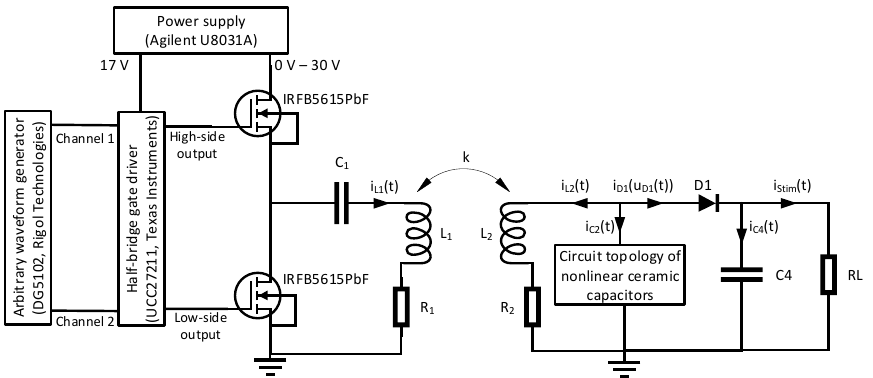
Figure 2. Inductively coupled system for power transfer consisting of an extracorporeal transmitter ( left ) and an implantable electronic circuit ( right ). The extracorporeal transmitter consists of a resonant half-bridge converter, a capacitor C 1 , an inductance L 1 and a loss resistor R 1 . The implantable electronic circuit consists of a parallel resonant circuit, which is composed of the inductance L 2 , loss resistor R 2 and a circuit topology of ceramic capacitors, a half-wave rectifier consisting of the diode D 1 and capacitor C 4 and an ohmic load R L representing the electrode impedance. The inductive coupling between the extracorporeal transmitter and the implantable electronic circuit is represented by the coupling factor k.